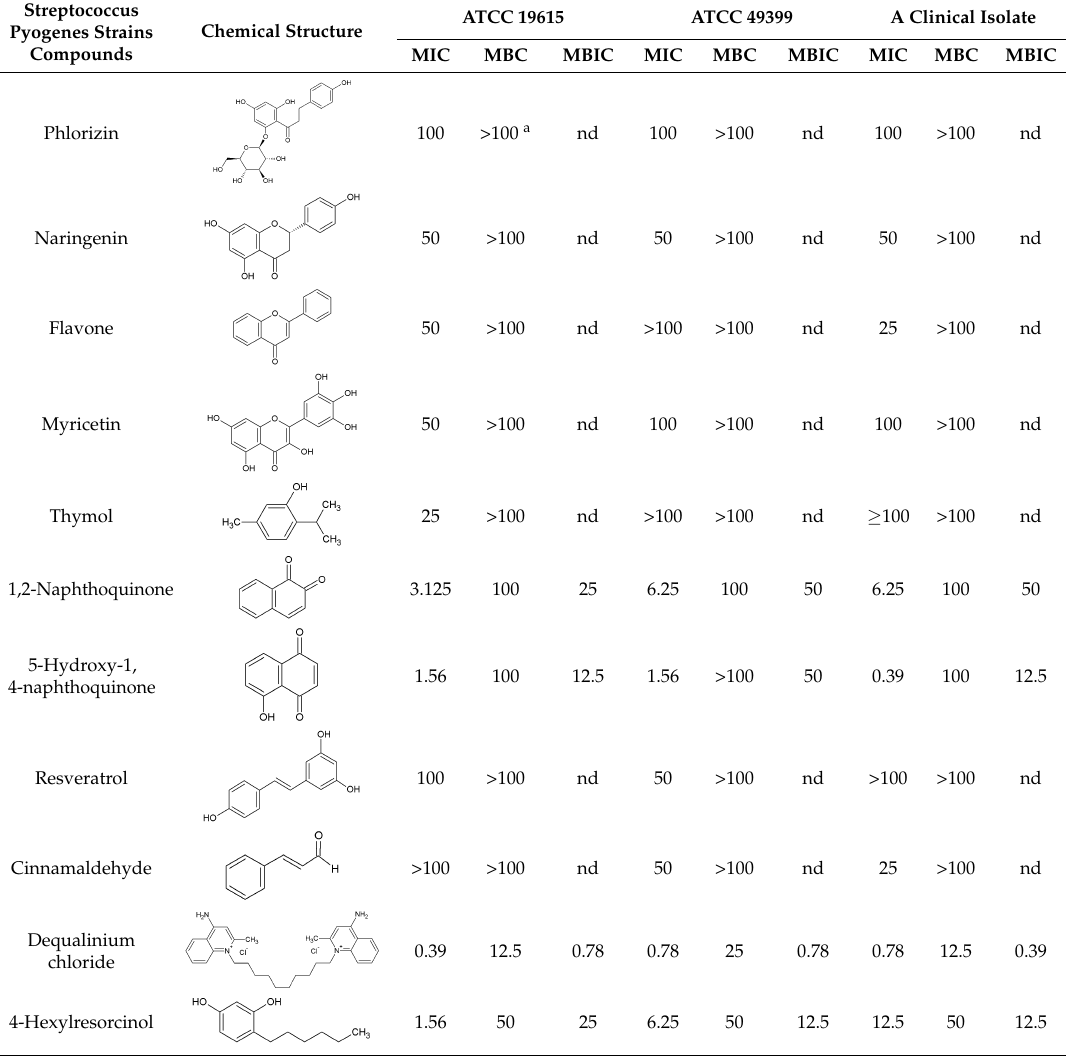
Table 1. Minimum inhibitory concentration (MIC, µ g mL − 1 ), minimum bactericidal concentration (MBC, µ g mL − 1 ) of 11 compounds and minimum biofilm inhibitory concentration (MBIC, µ g mL − 1 ) of the four most active compounds against three different strains of S. pyogenes. Streptococcus Pyogenes Strains Chemical Structure